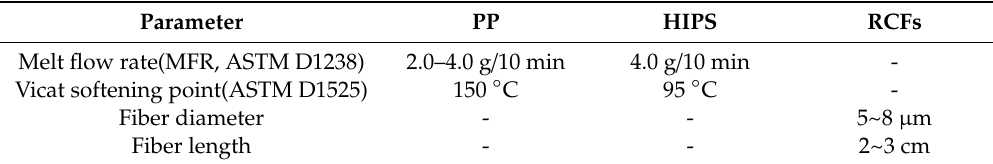
Table 1. A summary of the physical parameters for polypropylene (PP) and fillers. 1.